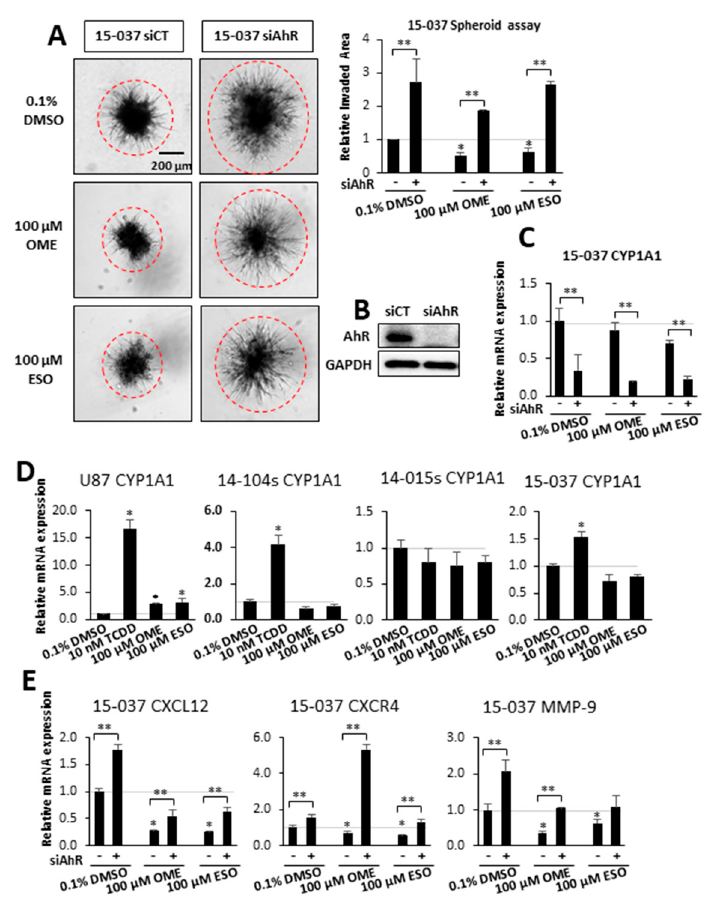
Figure 2. Effects of OME and esomeprazole (ESO) on AhR-dependent invasion and gene expression in wild-type 15-037 siAhR cells. Wild-type 15-037 and AhR-deficient 15-037 cells were treated with DMSO, 100 µM OME, and 100 µM ESO and spheroid cell invasion was determined and quantitated ( A ). AhR expression after knockdown by siAhR in 15-037 cells was determined by Western blot of whole cell lysates ( B ). Effects of OME and ESO on CYP1A1 expression in wild-type and AhR-deficient 15-037 cells ( C ), effects of 2,3,7,8-tetrachlorodibenzo- p -dioxin (TCDD), OME, and ESO in CYP1A1 induction in established and patient-derived GBM cells ( D ), and effects of OME and ESO on CXCL12, CXCR4, and MMP9 expression in wild-type and AhR-deficient 15-037 cells ( E ) was determined by real time PCR as outlined in the Materials and Methods. Results ( A , C – E ) are means ± SD for at least 3 determinations for each treatment group and significant ( p < 0.05) effects by the compounds alone (*) and attenuation of these responses after AhR knockdown (**) are indicated.